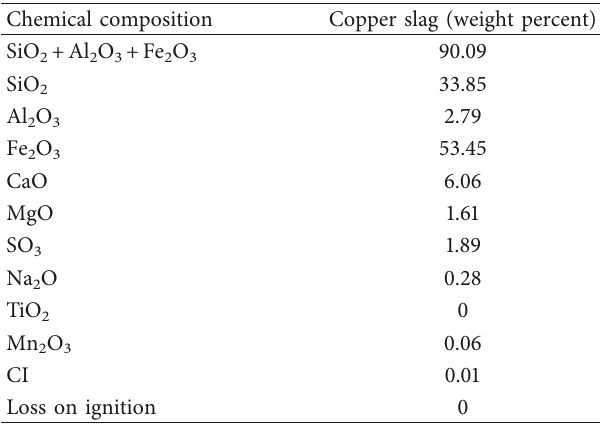
Table 1: Chemical composition of copper slag using energy dis- persive X-ray fluorescence